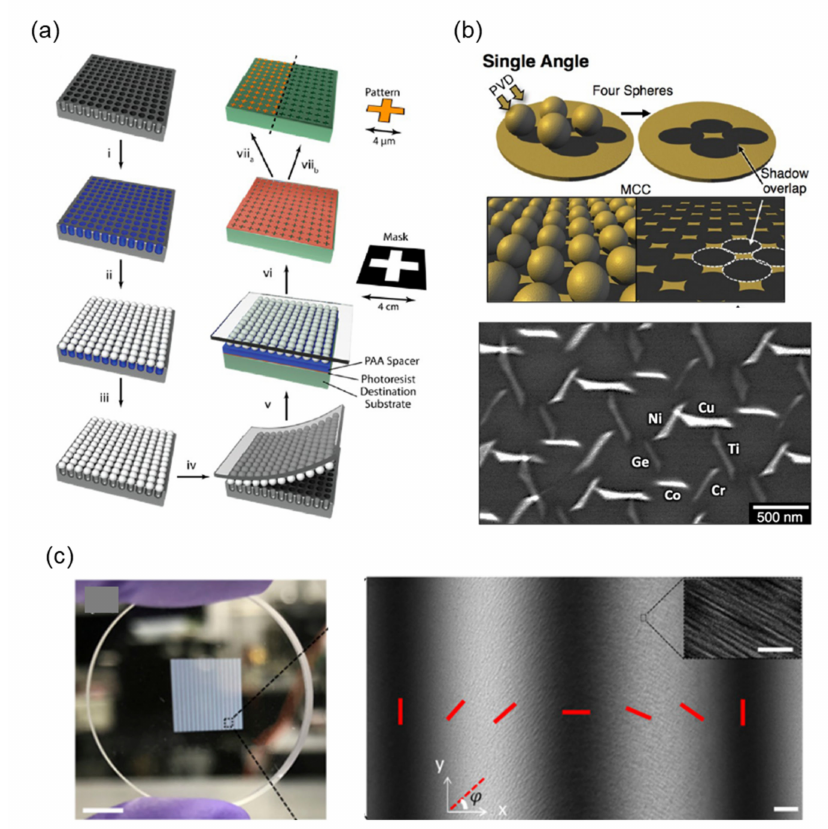
Figure 9. ( a ) Schematic of the TEMPL process [196]. ( b ) Schematic for deposition (top) of the shadow- sphere lithography process; SEM images (bottom) of multimaterial structures composed of 10 nm of either Cu, Ti, Cr, Co, Ge, or Ni [197]. ( c ) Photograph of a glass-based metasurface (left) with a pattern area of 8 mm × 8 mm; polariscope optical image (right) of the dotted square area of Figure 9c left. The red bars correspond to the orientation of the structures in one period (scale bar is 25 µ m). The inset (right) is the SEM image with a scale bar of 500 nm